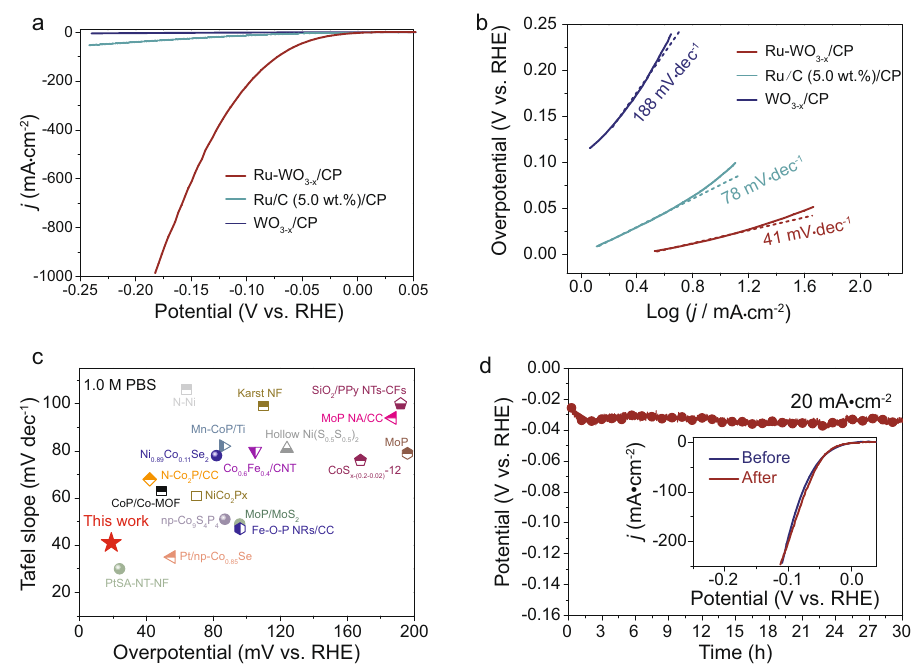
Fig. 3 | HER performance in 1.0M PBS. a LSV curves in 1.0M PBS. b The corre- sponding Tafel plots. c HER activity comparison of Ru-WO 3 − x /CP with other reported state-of-the-art electrocatalysts in 1.0M PBS. The corresponding